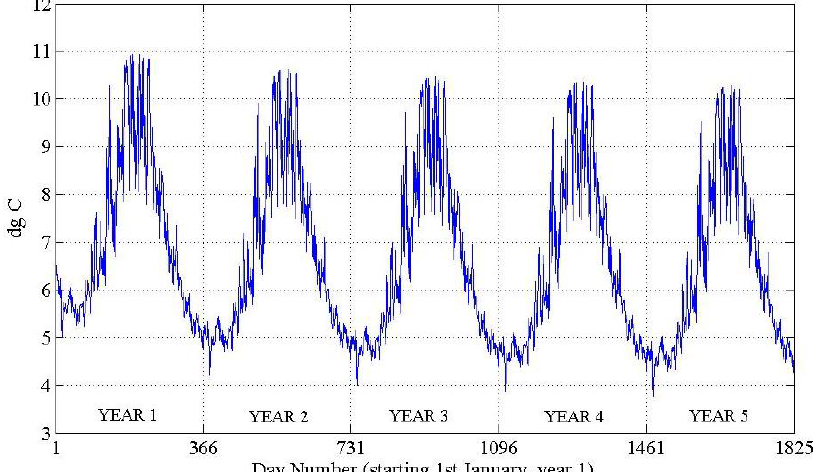
Figure 6. Minimum daily array inlet temperatures (detached